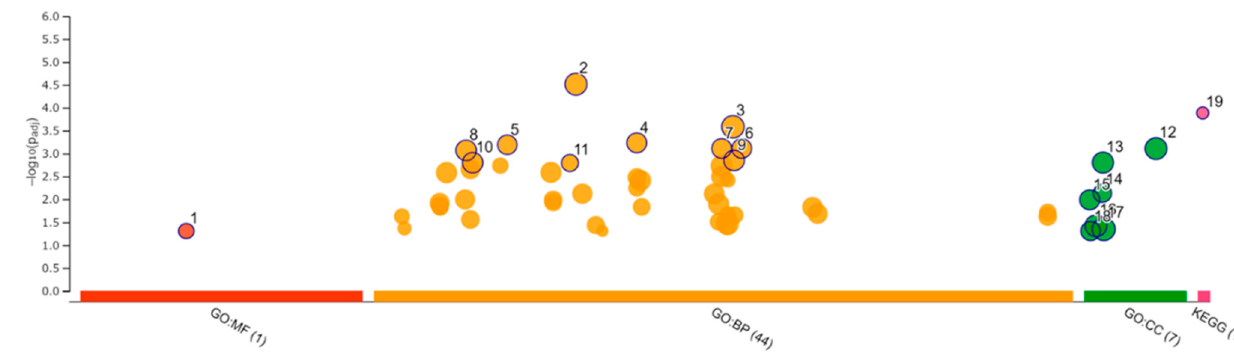
Figure 8. Functional enrichment analysis of 181 upregulated differentially expressed genes by g:Profiler. Results of enrichment analysis presented in the form of a Manhattan plot, where the x -axis shows the functional terms grouped by the color-coded of source database, while the y -axis shows the enrichment adjusted p -values in negative decimal logarithm scale. Dots in the graph indicate all enriched terms meeting the significance criterion of p < 0.05.